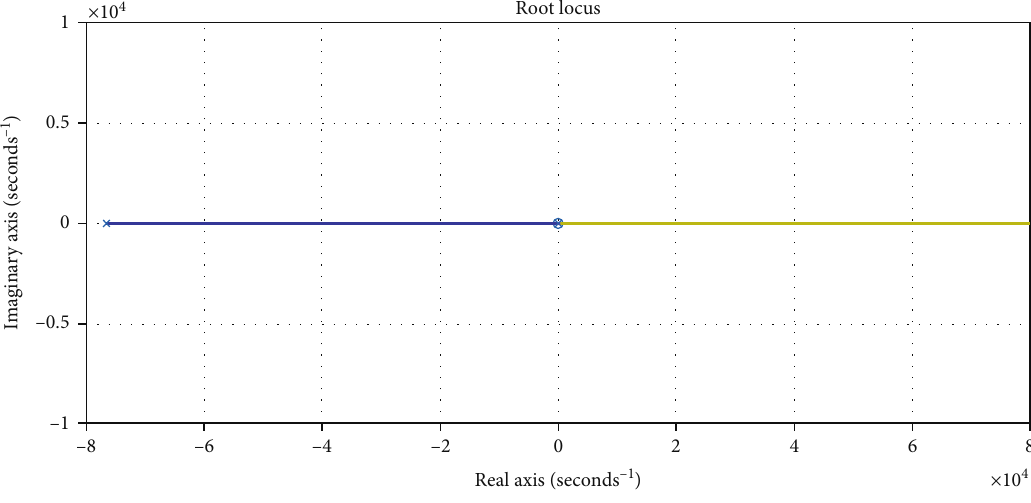
Figure 7: Root Locus of the transfer function sys